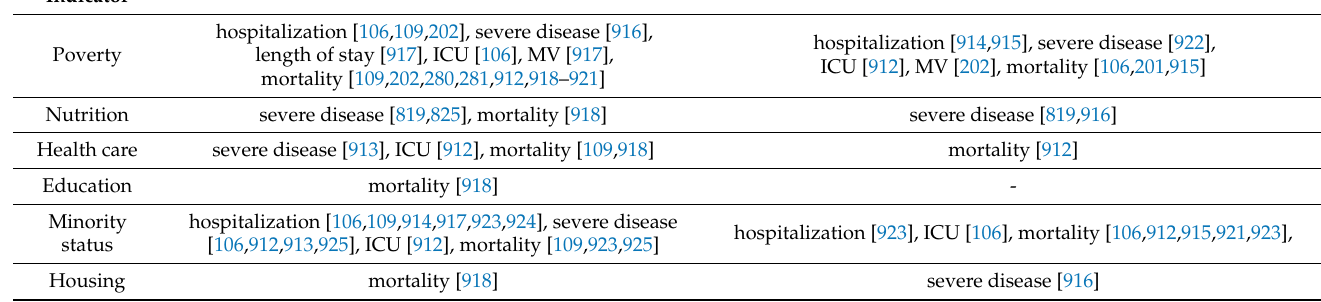
Table 7. Socioeconomic variables implicated in the outcome of COVID-19: studies with or without evidence of